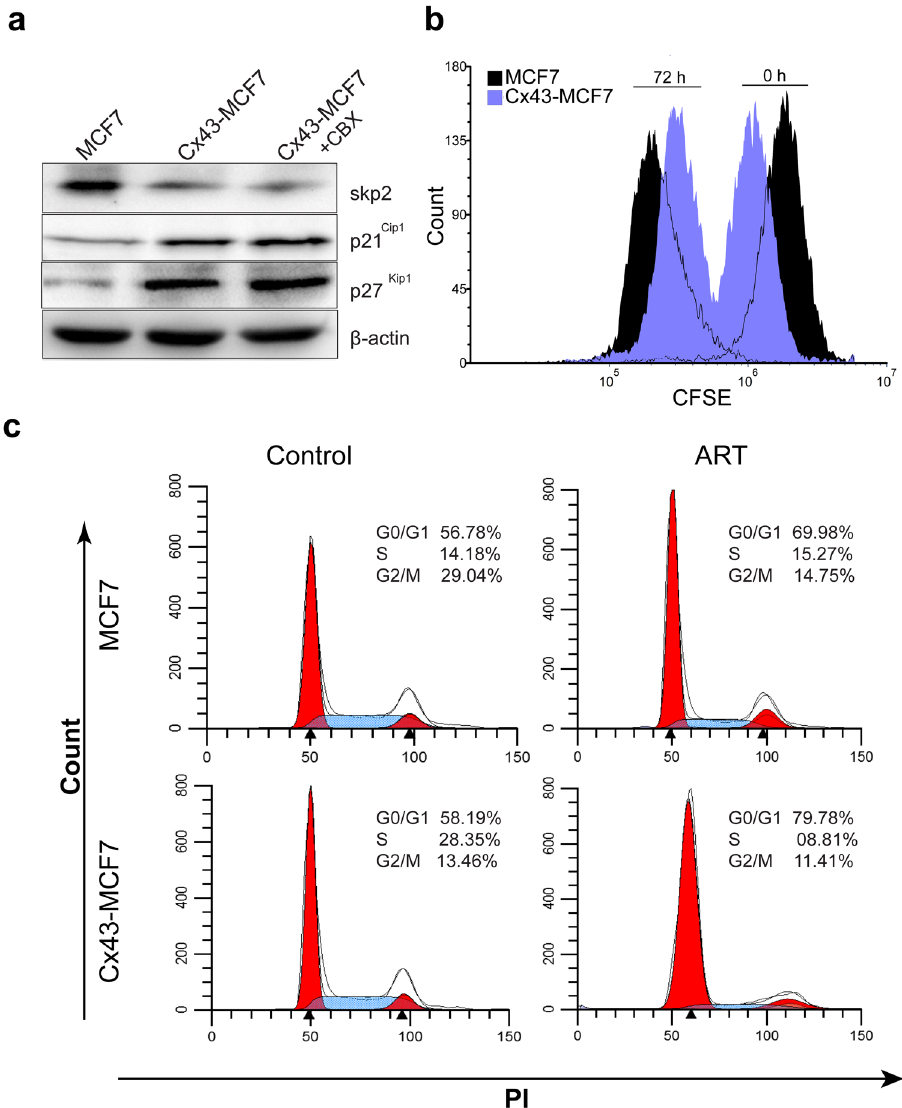
Figure 3. Anti-proliferative effect of Cx43 in MCF7 cells. ( a ) Regulation of anti-tumour proteins Skp2, p27 Kip1 , and p21 Cip1 were determined after overexpression of Cx43 in MCF7 cells. The densitometric analysis was used to quantitate band intensity (supplementary Fig. 3). ( b ) CFSE fluorescence intensity histogram of MCF7 and Cx43-MCF7 in a representative experiment. The histogram moved leftward after 72 h of incubation, indicating dye dilution due to cell division. ( c ) Cell cycle profiling of MCF7 and Cx43-MCF7 cells after treatment with ART. Data were analysed using ModFit LT